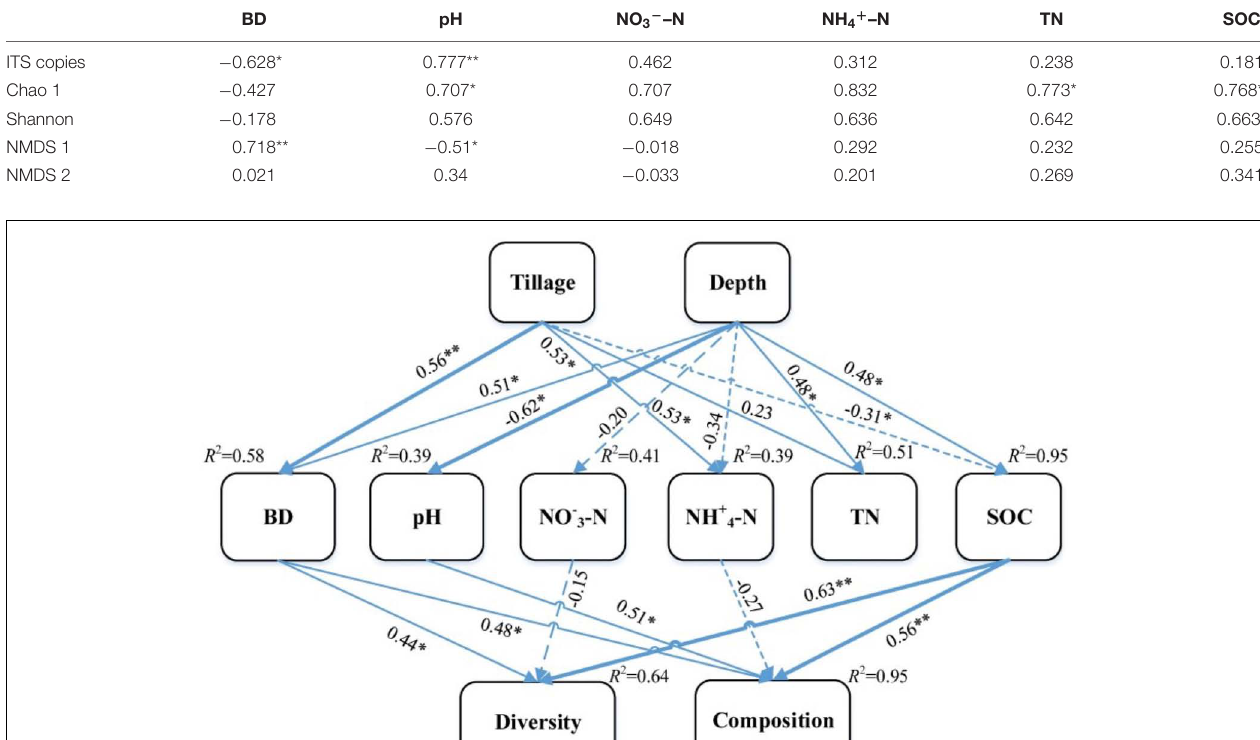
TABLE 3 | Correlation between soil fungal community and physicochemical properties (** p < 0.01; * p < 0.05).